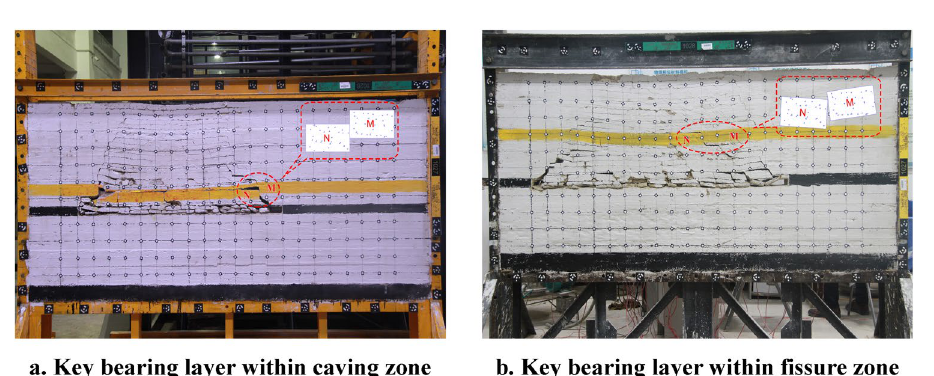
Figure 6. Comparison of the periodic fracture instability motion modes of the key bearing layer and movement characteristics of overburden